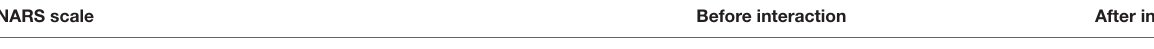
Table 3 | Mean values (sD) of the nars questionnaire before and after the interaction ( error and no error combined). nars scale before interaction after interaction S1: negative attitude toward situations of interaction with robots Mean = 2.07 (SD =